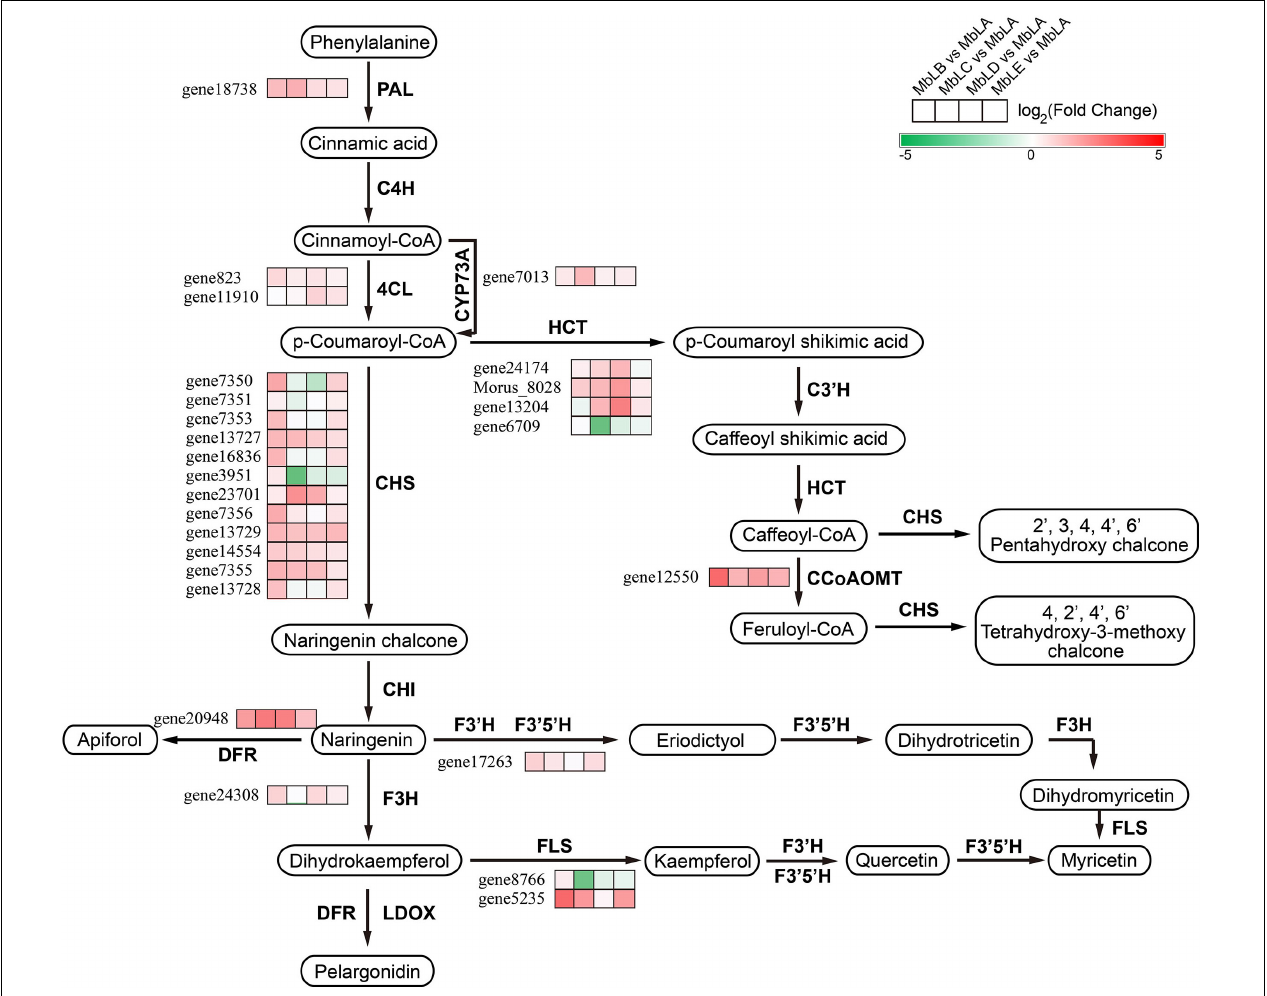
FIGURE 5 | Putative flavonoid biosynthesis pathway in mulberry leaves and gene expression profile of the key enzymes. PAL, Phenylalanine ammonia-lyase; C4H, Cinnamate 4-hydroxylase; 4CL, 4-coumaroyl-CoA ligase; CHS, Chalcone synthase; CHI, Chalcone isomerase; DFR, Dihydroflavonol reductase; F3H, Flavanone 3-hydroxylase; F3 (cid:48) H, Flavonoid 3 (cid:48) -hydroxylase; F3 (cid:48) 5 (cid:48) H, Flavonoid 3 (cid:48) 5 (cid:48) hydroxylase; LDOX, leucoanthocyanidin dioxygenase; FLS, Flavonol synthase; HCT, hydroxycinnamoyl